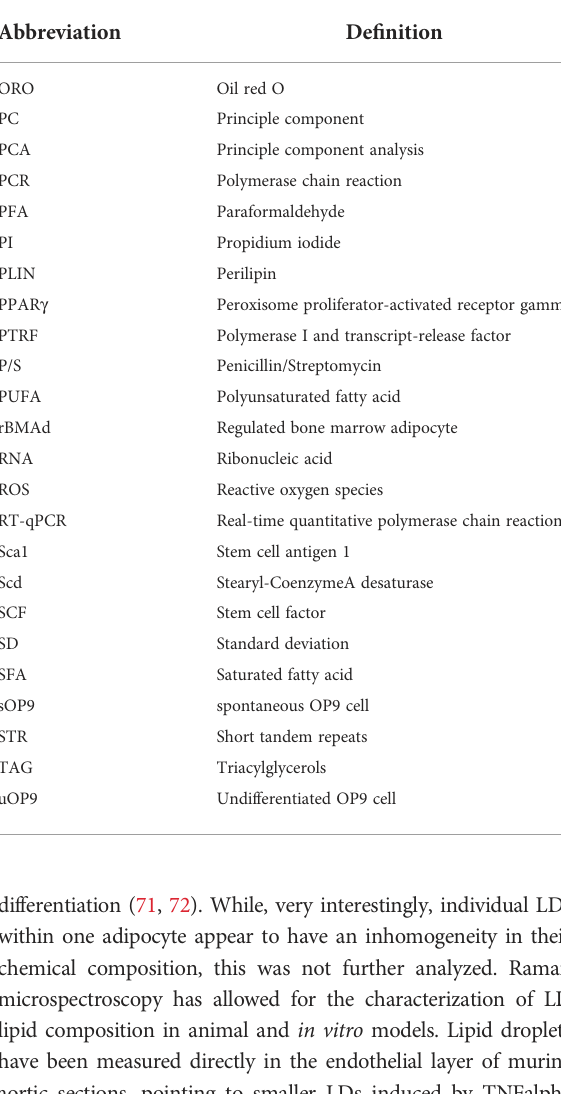
TABLE 2 List of general